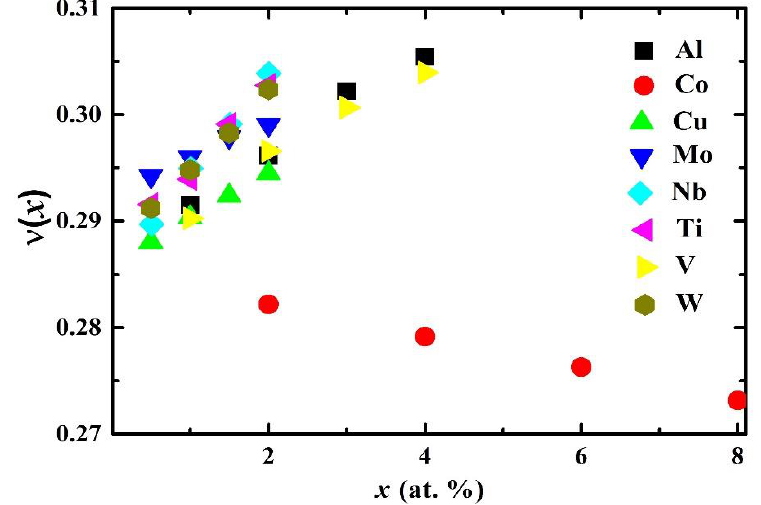
Figure 6. Theoretical Poisson’s ratio ν ( x ) of paramagnetic fcc Fe 0.6 − x Cr 0.2 Ni 0.2 M x (M = Al, Co, Cu, Mo, Nb, Ti, V, and W; 0 ≤ x ≤ 0.08) quaternary alloys as a function of the atomic concentration x .